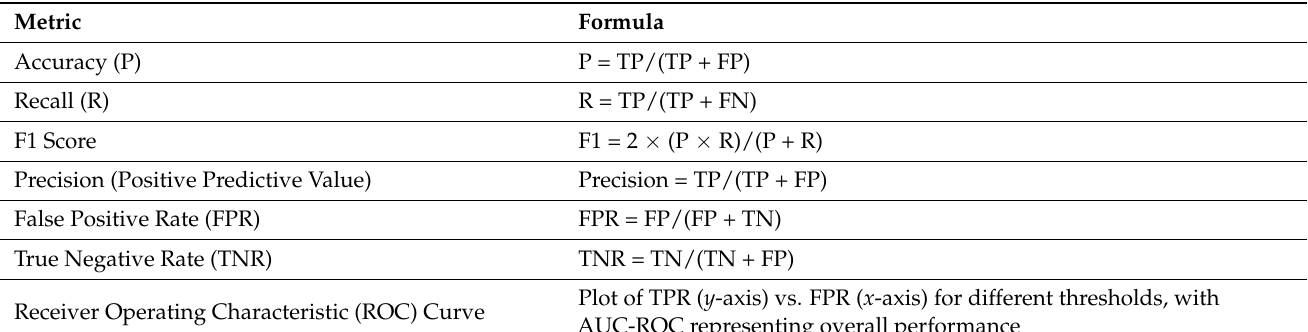
Table 3. Performance Metrics for Evaluating Tumor Treatment Incident Sampling Models.